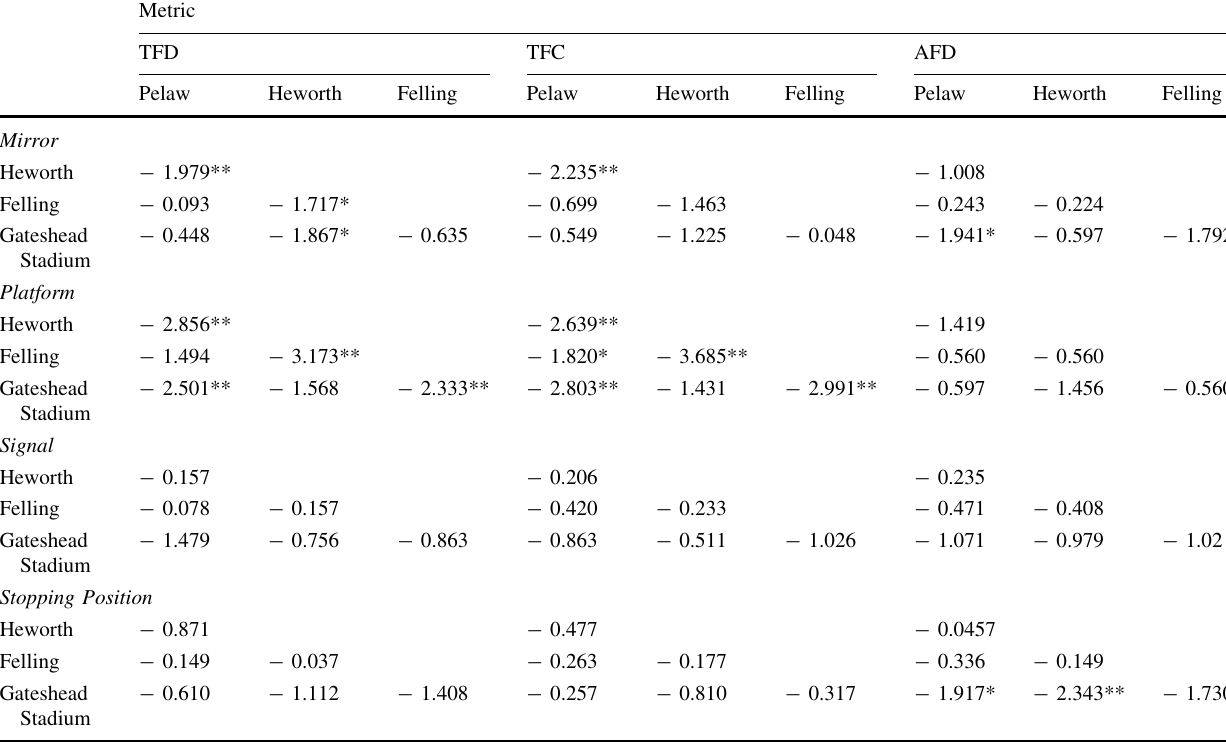
Table 6 Difference in gaze behaviour at different locations (arrivals)